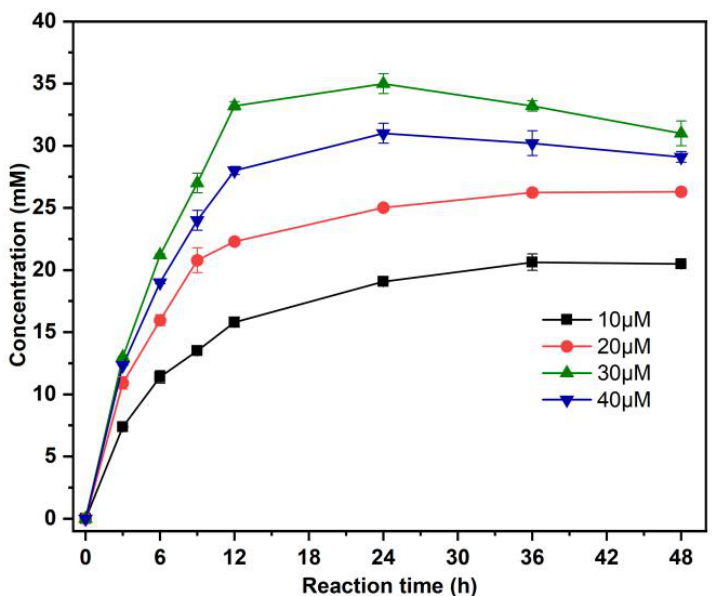
Figure 2. Effects of Pe AAOx dosage on the oxidation of veratryl alcohol. (Reaction conditions: [ Pe AAOx] = 10, 20, 30 and 40 µ M, [ Aae UPO] = 2 µ M, [veratryl alcohol] = 50 mM (pre-dissolved in acetonitrile), 30 ◦ C, pH 7 and 500 rpm).